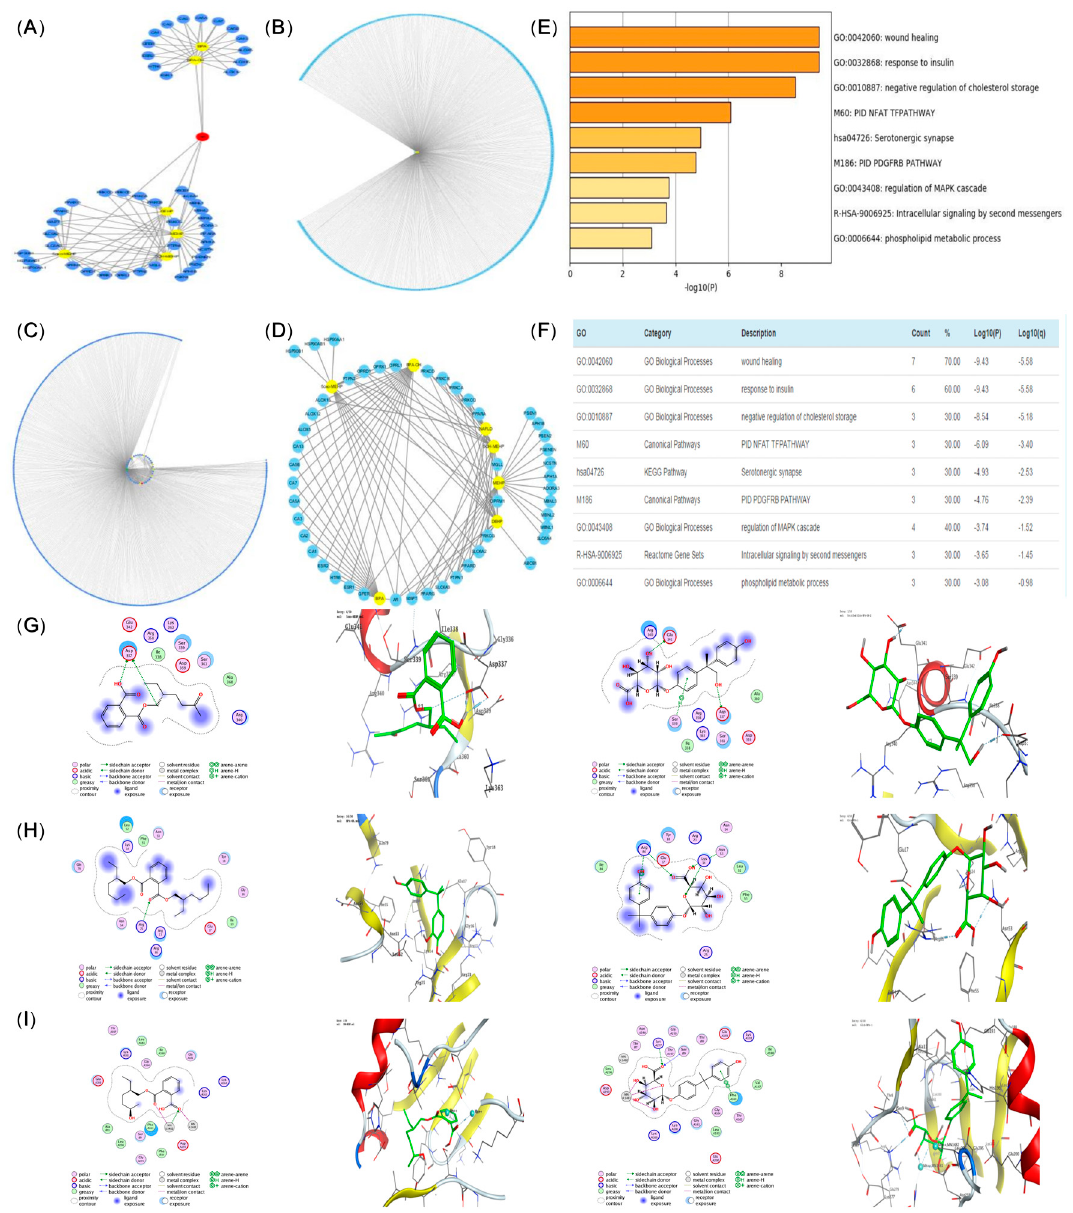
Figure 5. Compound − target − pathway network (blue represents gene targets, yellow represents metabolites, and diseases, red presents co-action targets) ( A , B ), Metabolite − targeted interaction network diagram ( C ). Compound − target − pathway network (blue represents gene targets, yellow represents metabolites and diseases, red presents co-action targets) ( D ), Heat map of target gene set pathway enrichment analysis ( E ), Target gene set pathway enrichment analysis ( F ). Molecular docking of DEHP and BPA prototypes and metabolites to five target proteins: PI3K, AKT, FOXO1 ( G − I